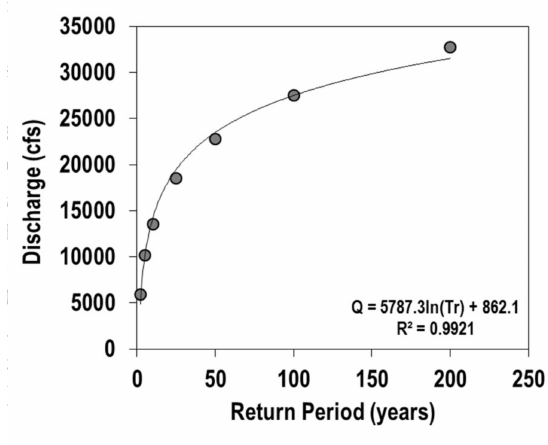
Figure A5. Log-Pearson Type III discharge (cfs) vs recurrence interval (years). Equation for annual peak discharge (Q) as a function of return period